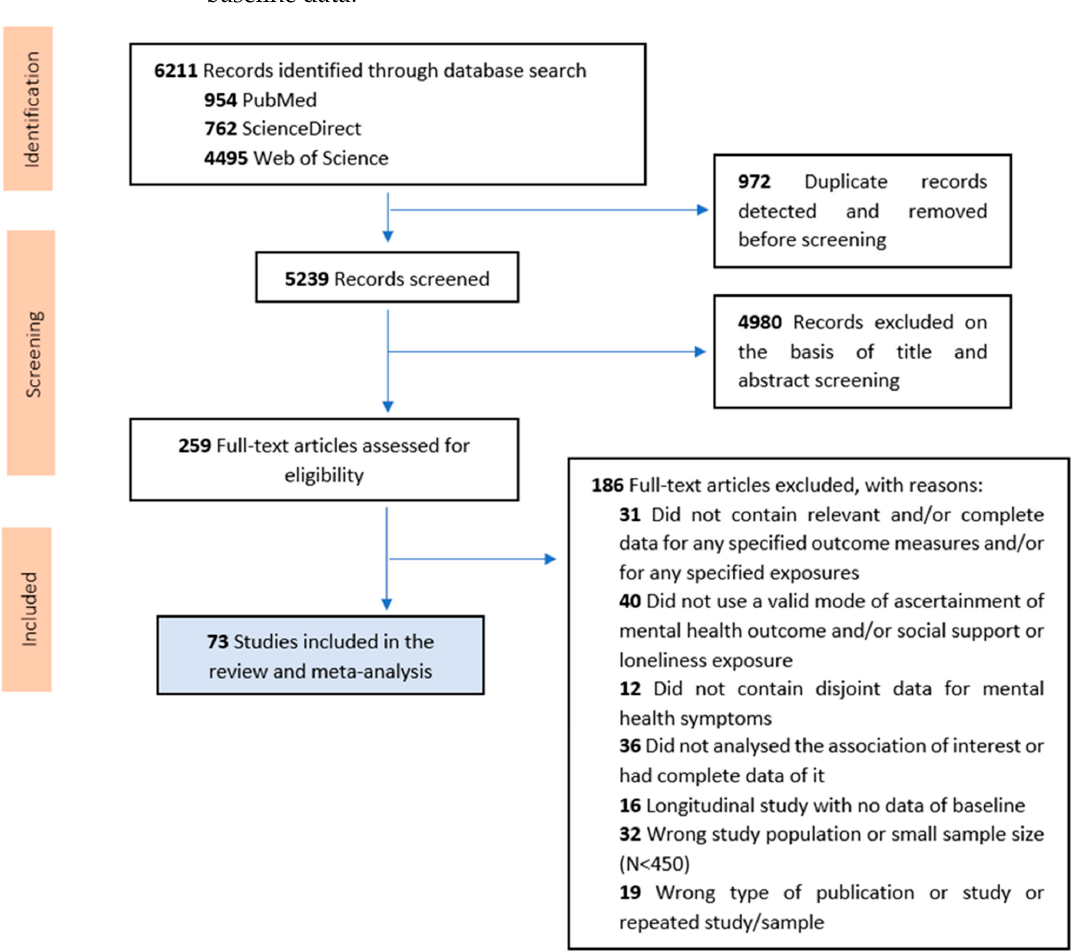
Figure 1. PRISMA flow diagram outlining results of the study selection process.